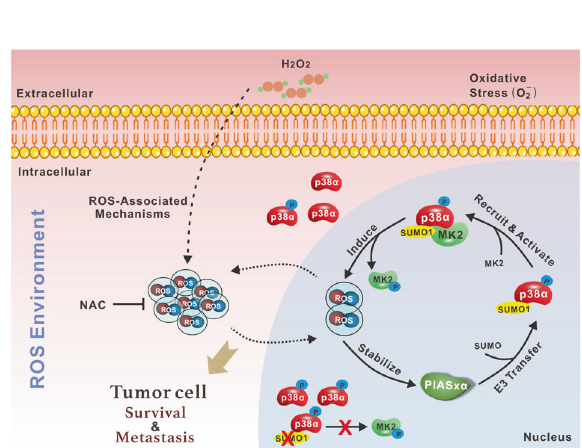
Fig. 6 ROS can stabilize PIASx α to promote p38 α -SUMOylation. a HEK293T cells were transfected with HA-tagged PIASs for 48 h, and cell lysates were incubated with puri fi ed GST-p38 α protein overnight at 4° C and subjected to immunoblotting analysis. b Immunoprecipitation was conducted to detect the endogenous interaction between PIASx α and p38 α in HGC27 cells. c HEK293T cells were co-transfected with FLAG-SUMO1, Myc-Ubc9, HA-p38 α -WT, and gradient HAPIASx α for 48 h; cell lysates were immunoprecipitated with anti-FLAG antibody for the SUMOylation assay. d HEK293T cells were transfected with FLAG-SUMO1, Myc-Ubc9, HA-p38 α -WT with or without PIASx α -siRNA, and cell lysates were immunoprecipitated for the SUMOylation assay. e , f HGC27 cells were treated with a gradient concentration of H 2 O 2 ( e ) or NAC ( f ) for 6 h before harvesting, and the cells were lysed for Western blotting. g HGC27 cells stimulated by H 2 O 2 or vehicle were treated with 50 μ M CHX for indicated times and cell lysates were subjected to immunoblotting (upper panel). The degradation rate is represented as a line diagram (lower panel). h HGC27 cells were treated with or without H 2 O 2 (0.8 mM) for 6 h and were harvested for detecting the SUMOylation level of endogenous p38 α by immunoprecipitation. i GEPIA online database was used to show the mRNA level of PIASx in GC tissue and normal gastric tissues (T: tumor; N: normal). j Immunoblotting for determination of PIASx α , pp38, and pMK2 levels in 5 pairs of GC tissues and adjacent normal tissues (A: adjacent normal gastric tissues; T: GC tissues). k – m The survival probabilities were predicted by the online database. OS: overall survival ( k ), PFS: progression-free survival ( l ), or PPS: post-progression survival ( m ). Patients with high or low PIASx (PIASx α and PIASx β ) expression are indicated in red or black line, respectively. HR hazard ratio. The p -value was calculated by a log-rank